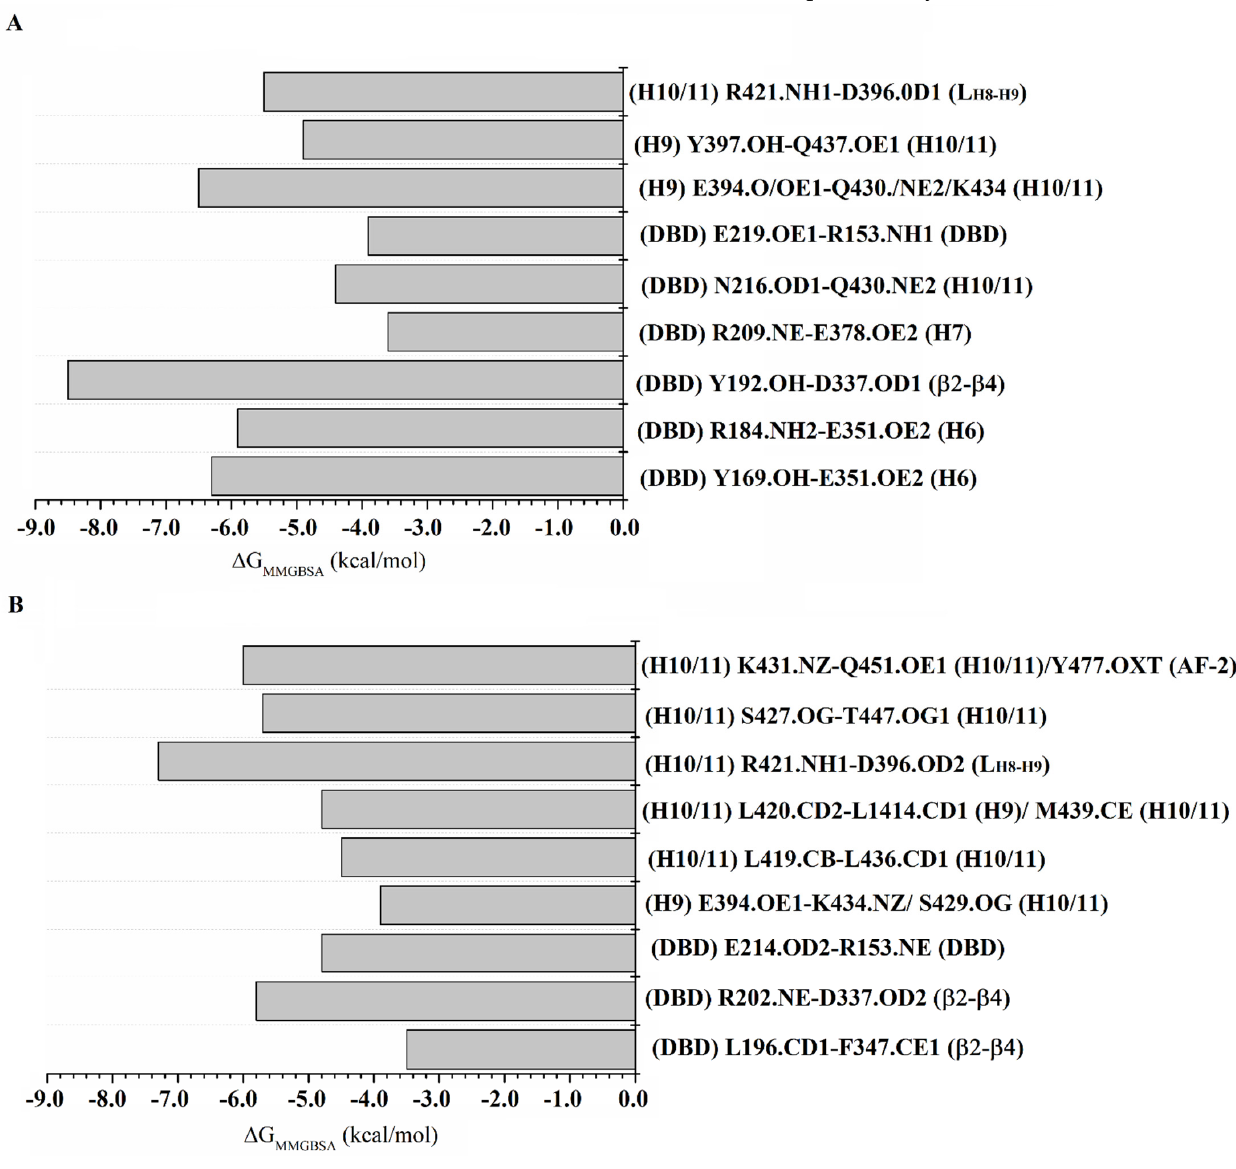
Figure 5. Per-residue free energy for protein-protein interactions of the RXR α -PPAR γ ( A ), and RXR α -PPAR γ -DNA ( B ) systems coupled to RZG and 9CR (values are in Kcal/mol). Residues at the left and right of the interaction correspond to RXR α and PPAR γ , respectively.